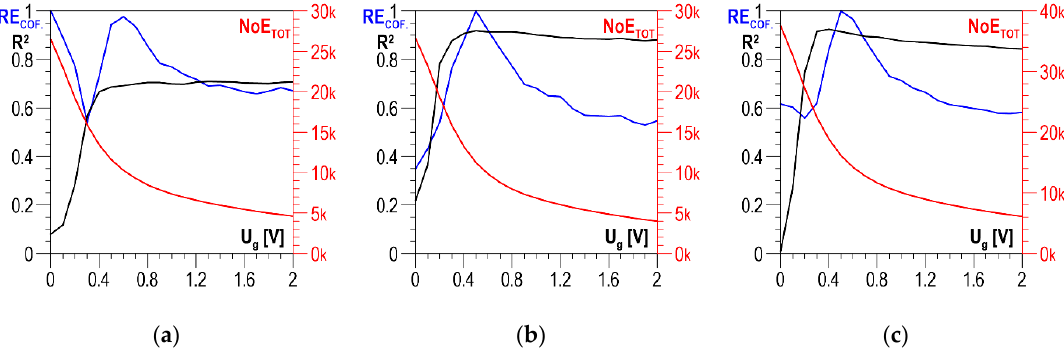
Figure 9. Averaged NoE TOT distributions and distributions of coefficients RE COF and R 2 as a function of threshold voltage U g —S235 steel ( a ) parallel direction; ( b ) normal direction; ( c ) absolute value.